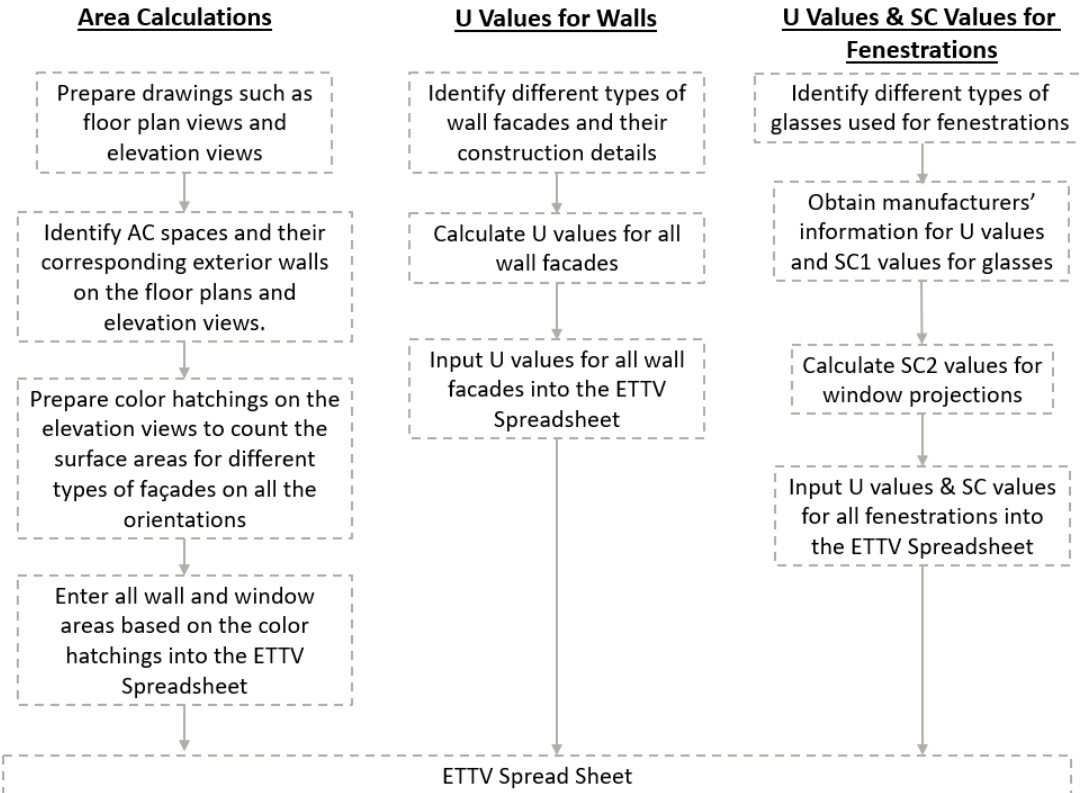
Figure 1. Traditional Envelope Thermal Transfer Value (ETTV) calculation process.